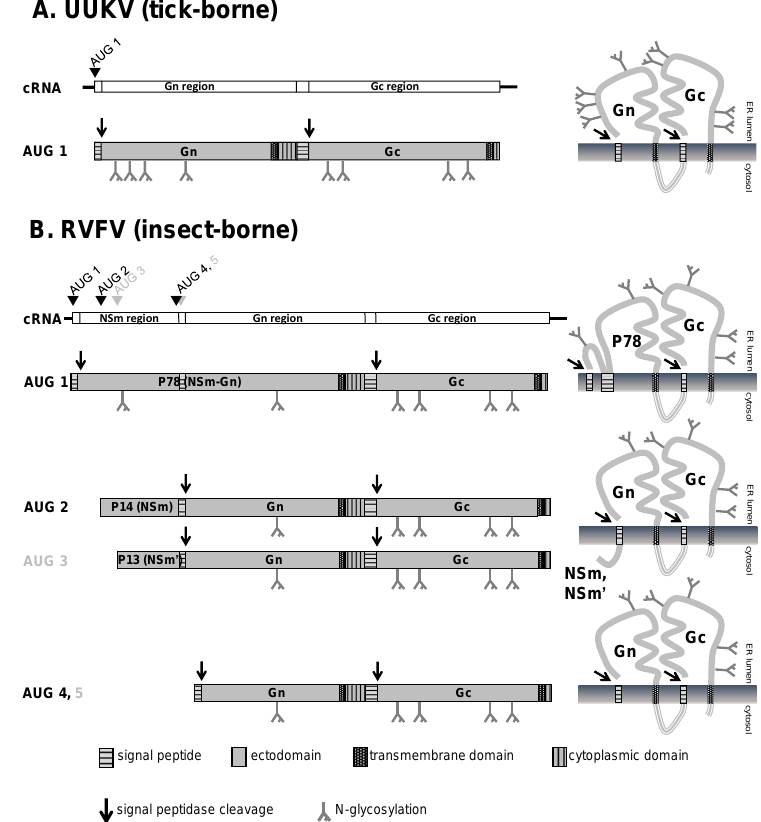
Figure 2. Coding and expression strategy of phlebovirus M-segments. Shown are the M-segments in antigenomic orientation (cRNA), the precursor glycoproteins and the membrane topology of the mature (glyco-) proteins. The antigenomic M-segment RNA serves as a template for viral transcription which results in a single mRNA. ( A ) UUKV as an example for tick-borne phleboviruses. The M-segment of tick-borne phleboviruses encodes only the two glycoproteins Gn and Gc. Translation of the mRNA yields one product, the Gn/Gc precursor. The precursor contains an N-terminal signal sequence preceding Gn and an internal signal sequence preceding Gc. Cleavage by the ER-associated signal peptidase complex yields Gn and Gc. Both Gn and Gc are glycosylated at N -glycosylation sites; ( B ) RVFV as an example for insect-borne phleboviruses. The M-segment of insect-borne phleboviruses encodes the non-structural protein NSm followed by the glycoproteins Gn and Gc. In case of RVFV translation initiation at different AUGs results in the expression of a nested set of polyproteins. Translation initiation at AUG 2 yields the NSm-Gn/Gc precursor protein. The precursor contains two internal signal sequences preceding Gn and Gc respectively. Cleavage by signal peptidase yields NSm, Gn and Gc. The Gn signal peptide acts as membrane anchor for NSm. Due to its membrane topology NSm is not glycosylated although it contains a potential N -glycosylation site. Translation at AUG 3 results in the expression of an N-terminal truncated NSm protein (NSm’) which is functionally equivalent to full-length NSm. Translation at AUG 1 yields the P78-Gc precursor protein. Signal peptidase cleaves the pre-protein after the signal sequences preceding NSm and Gc but not after the signal sequence preceding Gn which might act as membrane anchor instead. P78 is glycosylated at the N -glycosylation sites in the NSm and the Gn region. Note the different membrane topology of the NSm region in P78 (translation initiation at AUG 1) compared to NSm or NSm’ (translation at AUG 2 or AUG 3). Although P78 and Gc interact with each other, Gc might be unstable in the absence of Gn and therefore might be degraded in the ER. Translation at AUG 4 or 5 yields the Gn/Gc pre-protein. Signal peptidase cleaves the pre-protein after the signal sequences preceding Gn and Gc. Both Gn and Gc are N -glycosylated. The in vivo relevance of translation initiation at AUG 3 and 5 is not